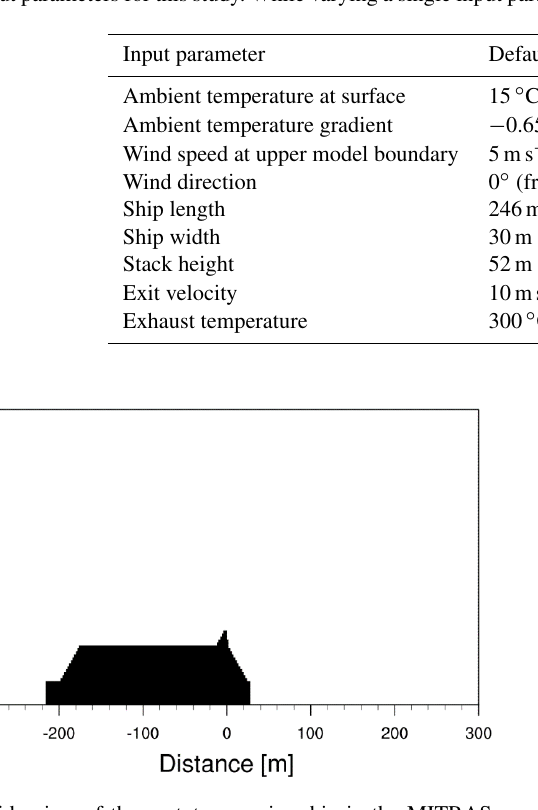
Figure 3. Side view of the prototype cruise ship in the MITRAS domain with the x axis located at the stack